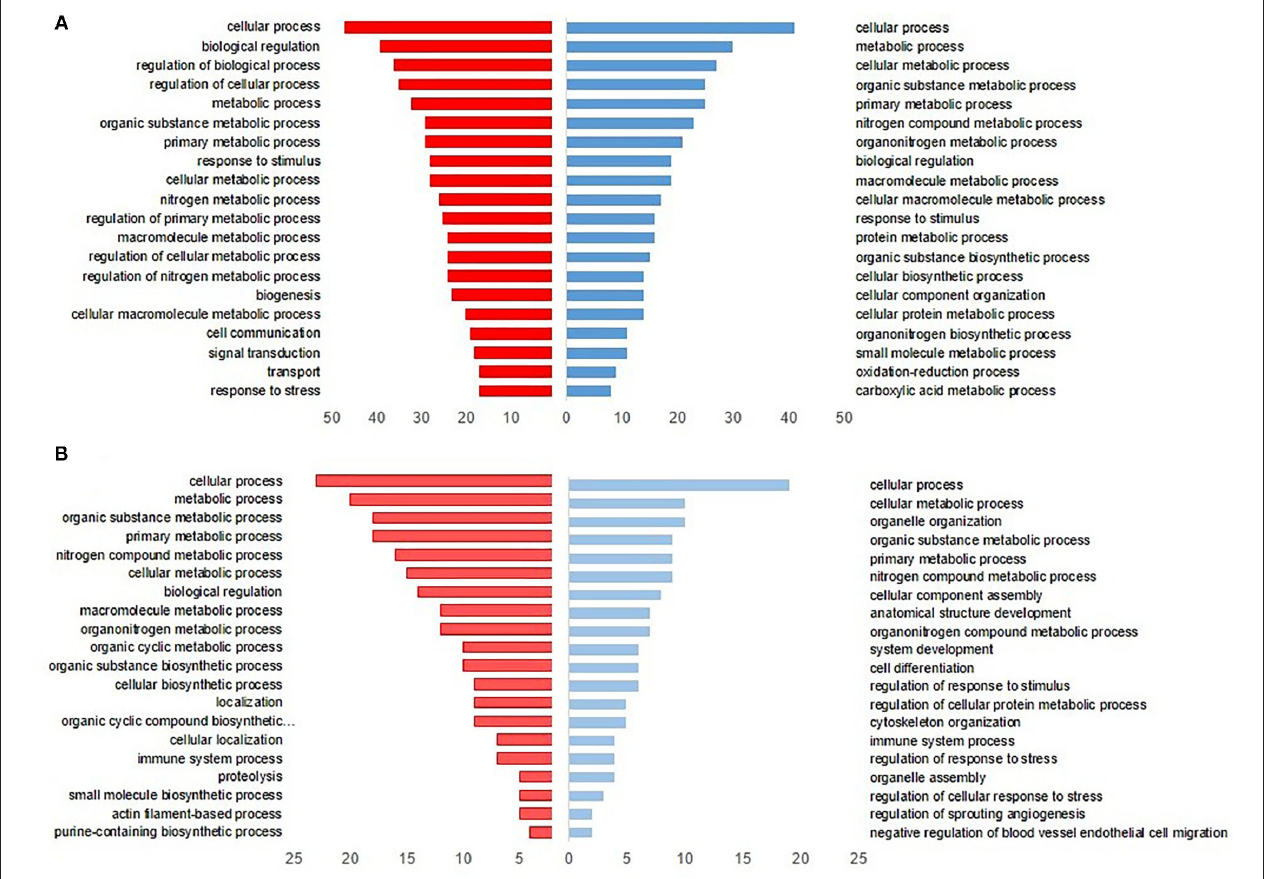
FIGURE 2 | Gene Ontology (GO) enrichment analysis of intestinal differentially expressed proteins from broilers exposed to lactic acid bacteria (L) in ovo (A) at the day of hatch and (B) by 10 days of age. The blue bars to the right indicate the top 20 GO-enriched terms by upregulated proteins. The red bars to the left represent the top 20 GO terms enriched by downregulated proteins, while the axis at the bottom is the number of proteins in each biological